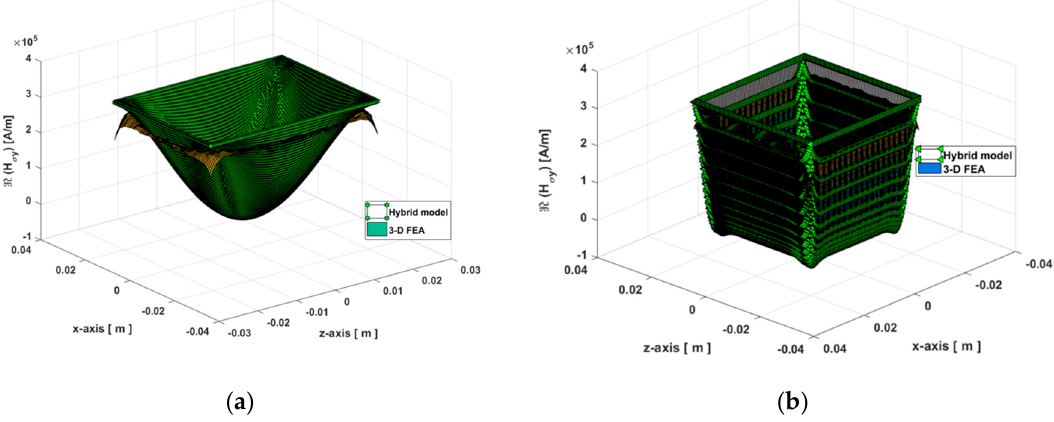
Figure 14. Evolution of H σ y in the massive conductive part with I max = 7.78 A at t = 0 s and h mp = 6mm for: ( a ) f = 50Hz, and ( b ) f = 1600 Hz .